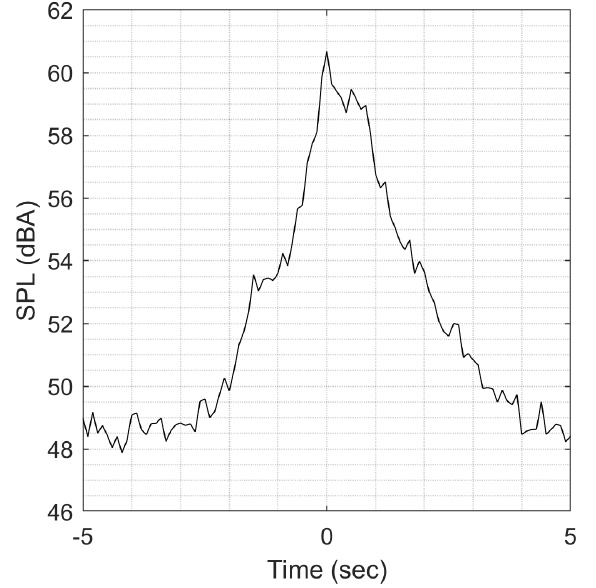
Figure 8. Measured flyover test (5 m altitude, 90 ◦ angle).